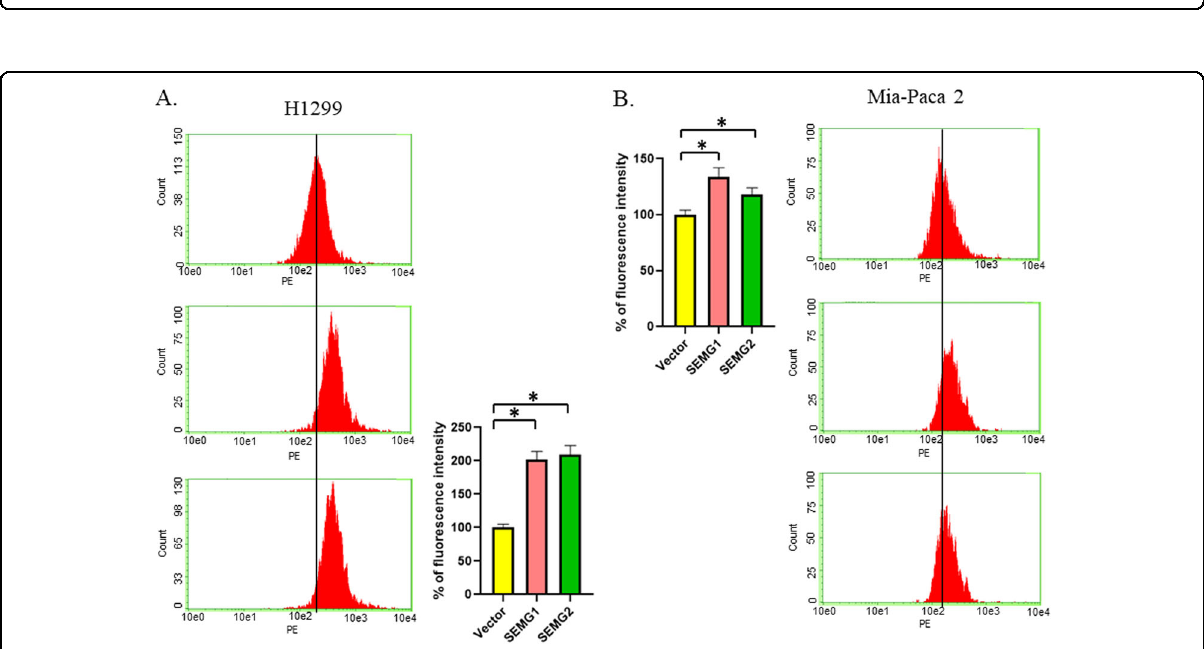
Fig. 6 SEMG1 and SEMG2 up-regulate glycolysis and respiration. SeaHorse ® pro fi ling of H1299 cells with stable overexpression of SEMG1, SEMG2 or control vector. SEMGs elevate A glycolysis and B respiration; ECAR extracellular acidi fi cation rate, OCR oxygen consumption rate. C Energy map showing increased energetic status of SEMGs-overexpressing related to control cells. Three biological replicates were used for quanti fi cation, data are presented as mean ± S.D., * P < 0.05.